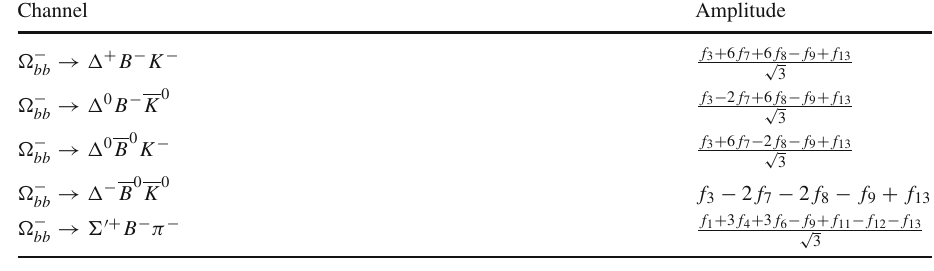
Table 33 Doubly bottom baryon decays into a bottom meson, a light baryon(10) induced by the charmless b → d transition and a light meson